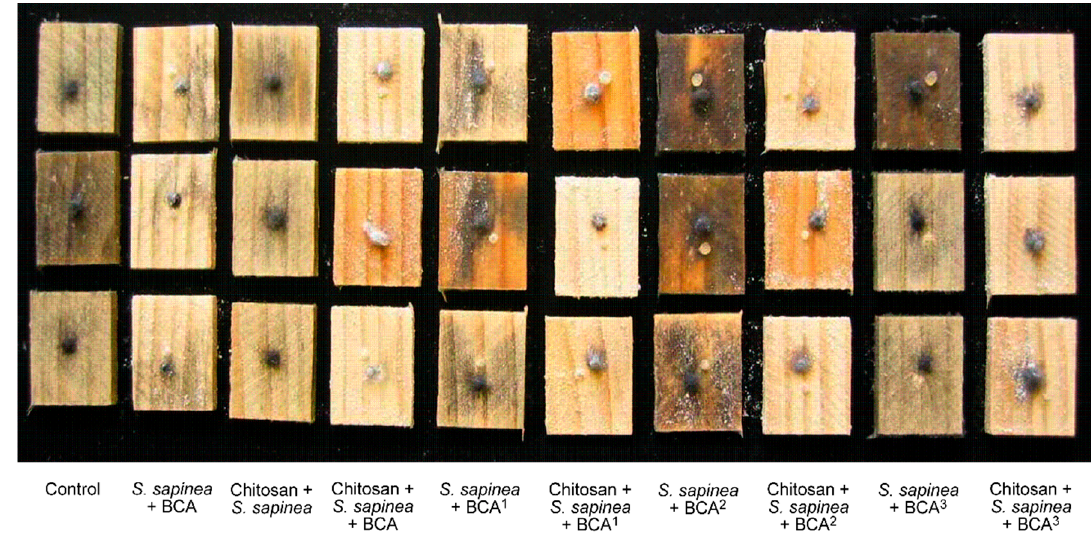
Figure 2. Effect of chitosan and BCA on S. sapinea after 24 days of incubation. Photograph showing three replicates per treatment. BCA 1 — Trichoderma was inoculated after a one day delay; BCA 2 — Trichoderma was inoculated after a two day delay; BCA 3 — Trichoderma was inoculated after a three day delay.